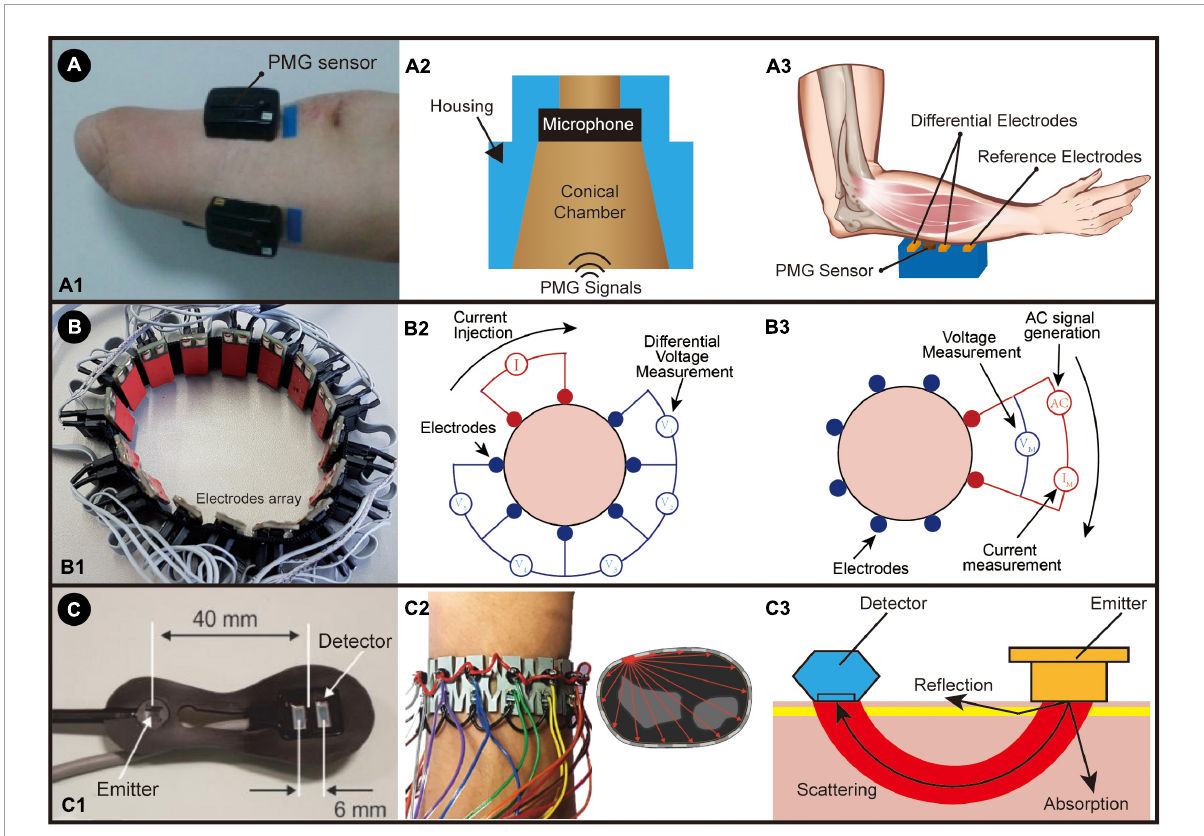
FIGURE5 (A) The PMG system: (A1) The placement of a hybrid EMG-PMG sensor on an amputee. Adapted from Guo et al. (2017a). Copyright 2017, IEEE; (A2) An illustration of PMG sensor; (A3) An illustration of PMG sensor working with surface electromyography (hybrid EMG-PMG). (B) The EIT system: (B1) wrist-band setup for EIT system; (B2) the illustration of two-terminal configuration measurement; (B3) the illustration of four-terminal configuration measurement. (C) NIR system: (C1) the portable NIRS optic array developed by Everdell et al. (2013) A: light source, B: photodiode detectors. Reproduced with permission (Everdell et al., 2013). Copyright 2013, Elsevier; (C2) Operation principle of SensIR: one emitter is on, and all the receivers will capture the scattering light through the tissue, which is repeated for all the emitters. Adapted from McIntosh et al. (2017). Copyright 2017, ACM; (C3) illustration of NIR